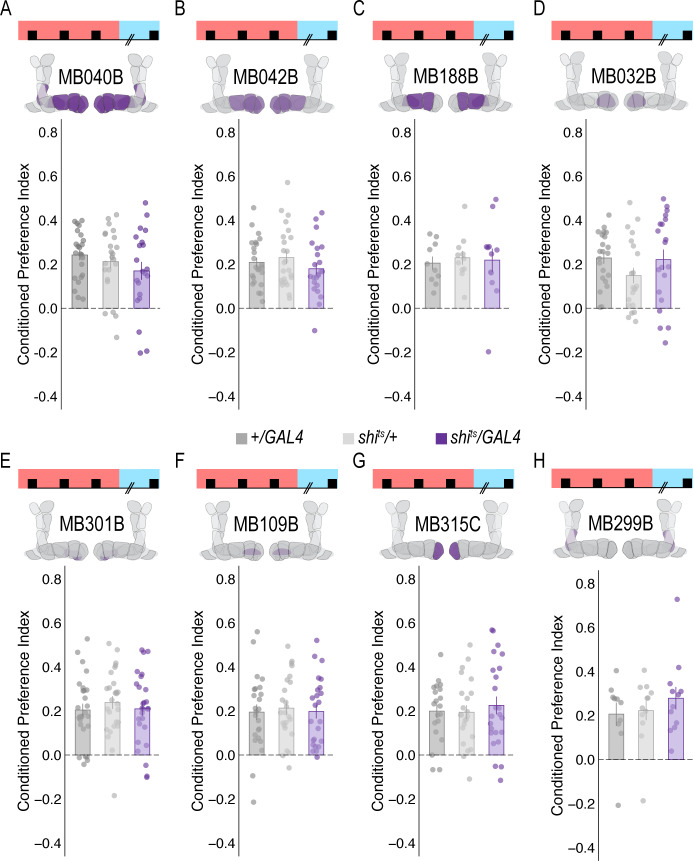
Subsets of PAM DANs are dispensable for encoding alcohol-associated preference.(A–H) Using thermogenetics to inactivate neurotransmission during acquisition in dopaminergic neurons with varying expression patterns did not disrupt alcohol-associated preference. Split-Gal4 lines tested are ordered by MB innervation patterns. Bar graphs illustrate mean +/- standard error of the mean. Raw data are overlaid on bar graphs. Each dot is an n of 1, which equals approximately 60 flies (30 per odor pairing). One-way ANOVA was used to compare mean and variance.